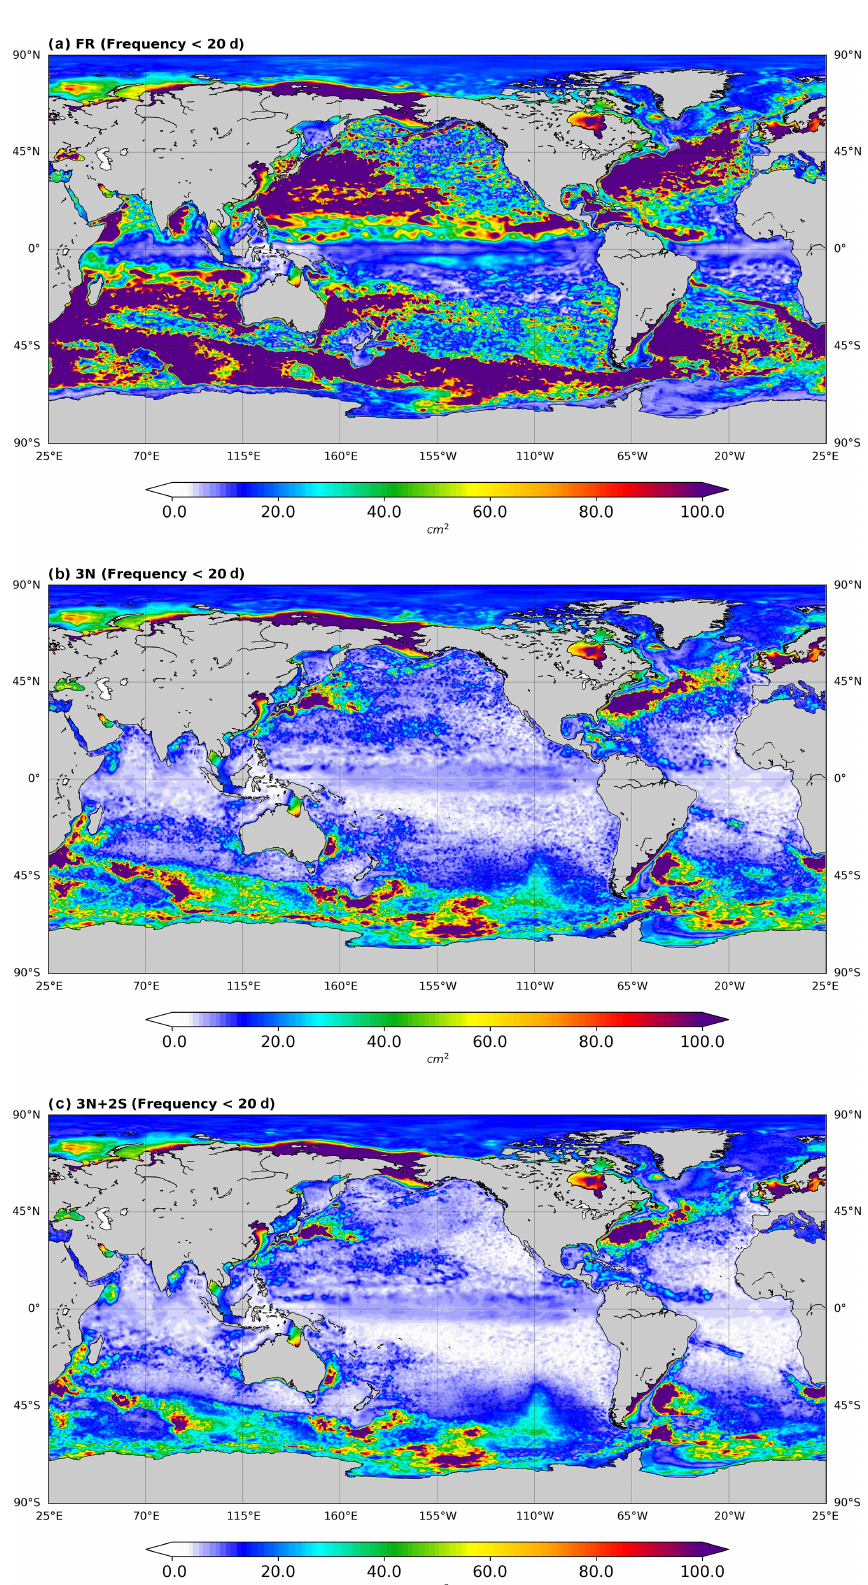
Figure 8. Global maps of SSH analysis error (NR – model analysis; timescales < 20d) variance (in cm 2 , 2015). (a) Free run (FR); (b) with three nadirs (3N); (c) with three nadir and two wide-swath instruments (3N + 2S). https://doi.org/10.5194/os-18-609-2022 Ocean Sci., 18, 609–625,